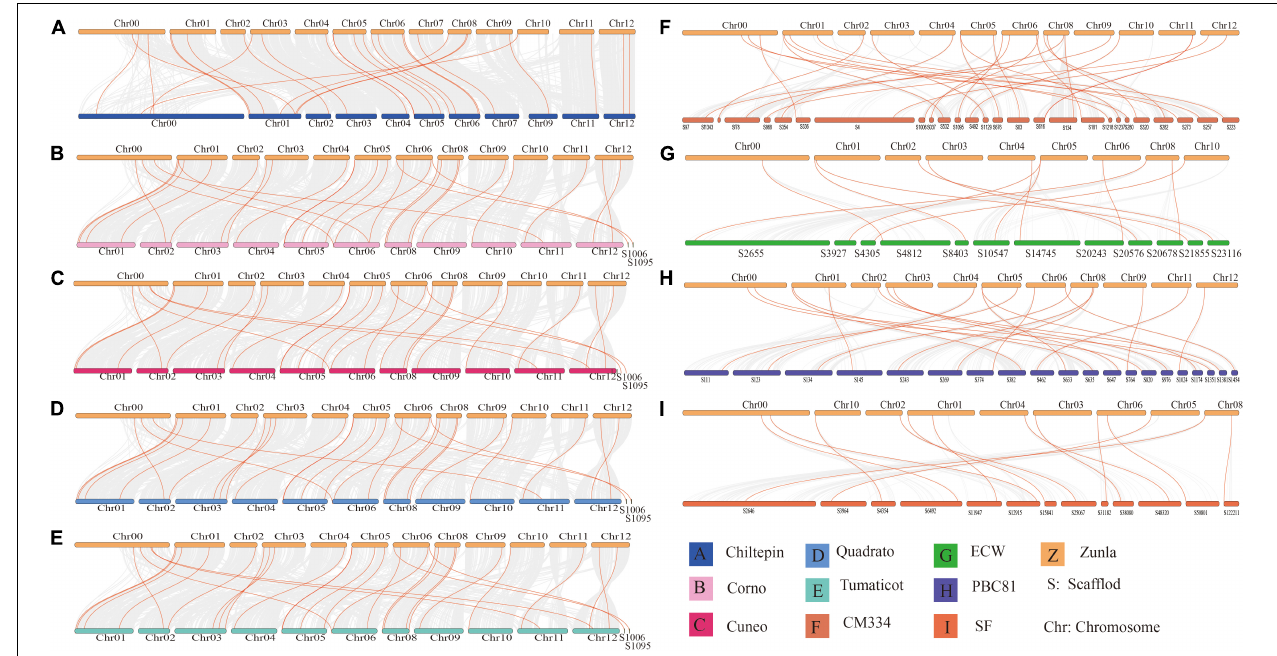
FIGURE 5 | Collinearity analysis of CaNHX gene in pepper. (A) Chiltepin; (B) Corno; (C) Cuneo; (D) Quadrato; (E) Tumaticot; (F) CM334; (G) ECW; (H) PBC81; (I) SF. Z: Zunla-1.